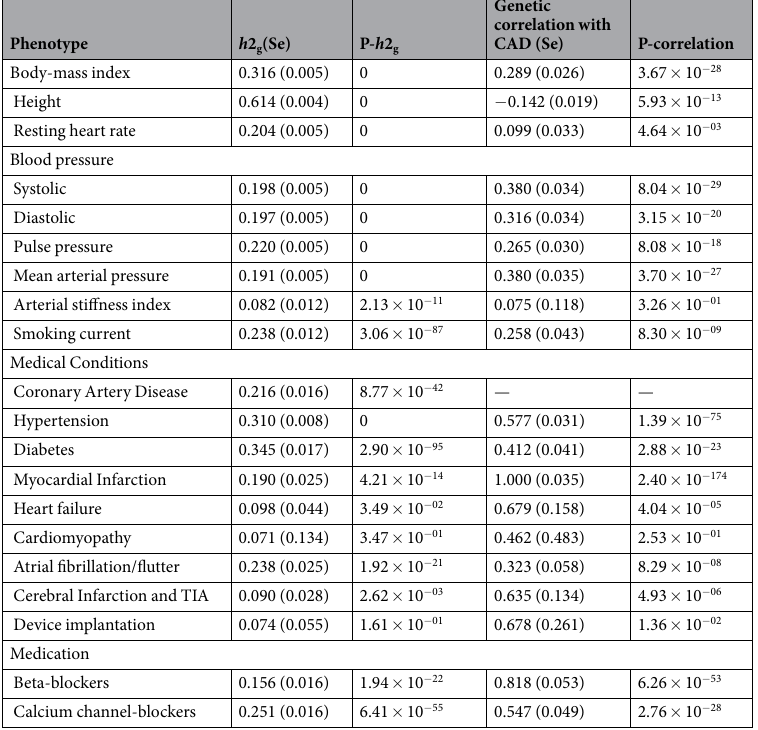
Table 4. Heritability estimates for cardiovascular traits and the shared heritability between each trait and CAD in all UK Biobank Participants based on common genetic variation under the additive model ( h 2 g ). For dichotomous traits, the heritability on the observed 0-1 scale was transformed to h 2 g on the